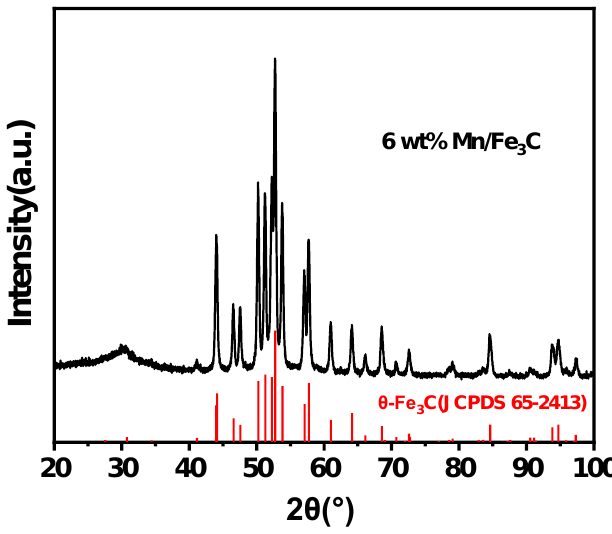
Figure 6. XRD pattern of 6 wt% Mn/Fe 3 C.